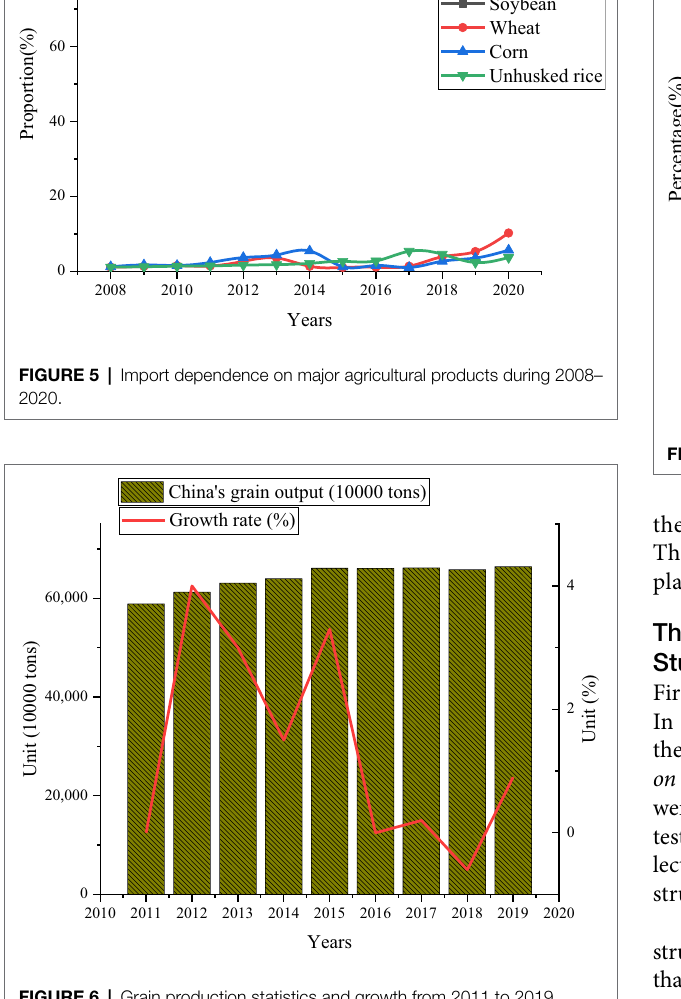
FIGURE 6 | Grain production statistics and growth from 2011 to